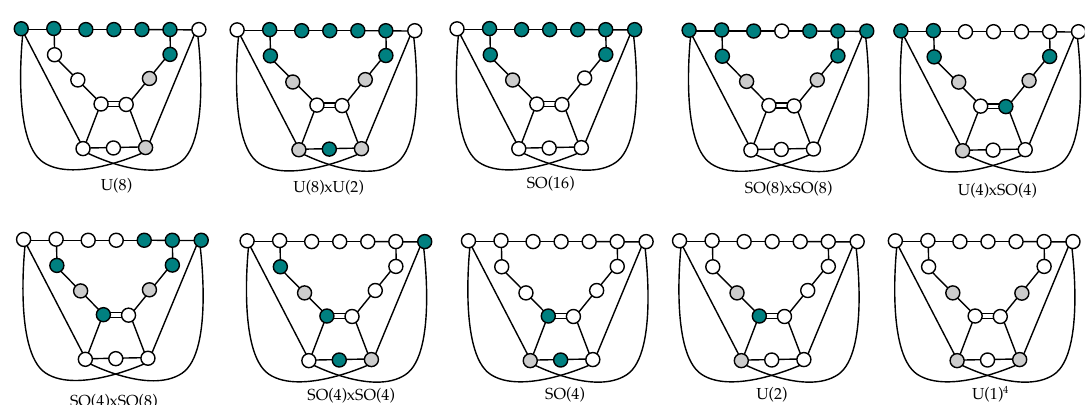
Figure 23. The possible embeddings of the BG-CFDs into the marginal CFD, which is shown at the top, for SU(2 n + 1) + 2 AS + 8 F . Below the diagrams we note the classical (cid:13)avor symmetry for the putative weakly coupled